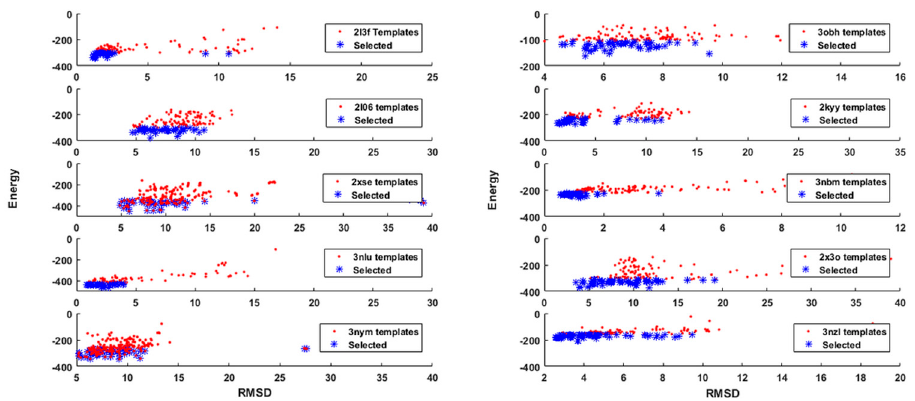
Figure 3. Template energy and energy selection.